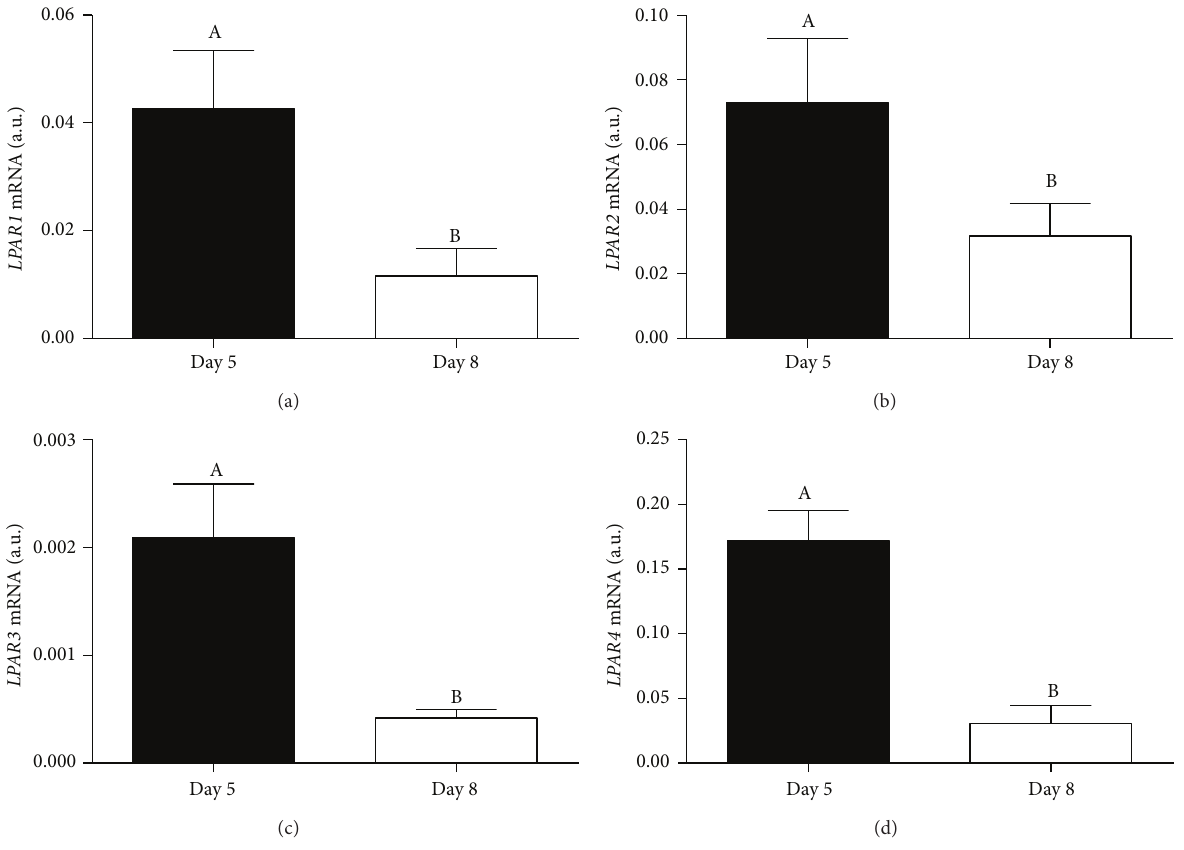
Figure 4: Transcription levels of genes coding for LPA receptors ((a) LPAR1 ; (b) LPAR2 ; (c) LPAR3 ; (d) LPAR4 ) in late cleavage (Day 5) and blastocyst (Day 8) stage bovine in vitro produced embryos. Columns with different superscripts differ significantly: AB, 𝑃 < 0.05